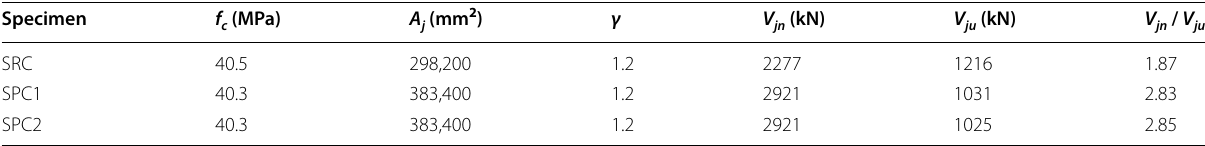
Table 4 Joint shear strength of test